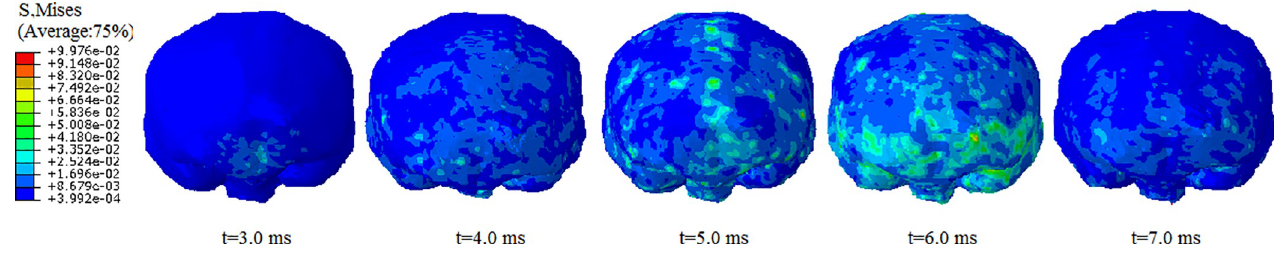
Fig 15. Propagation of stress wave in the brain under temporal collision. (A) t = 3.0 ms. (B) t = 4.0 ms. (C) t = 5.0 ms. (D) t = 6.0 ms. (E) t = 7.0 ms.